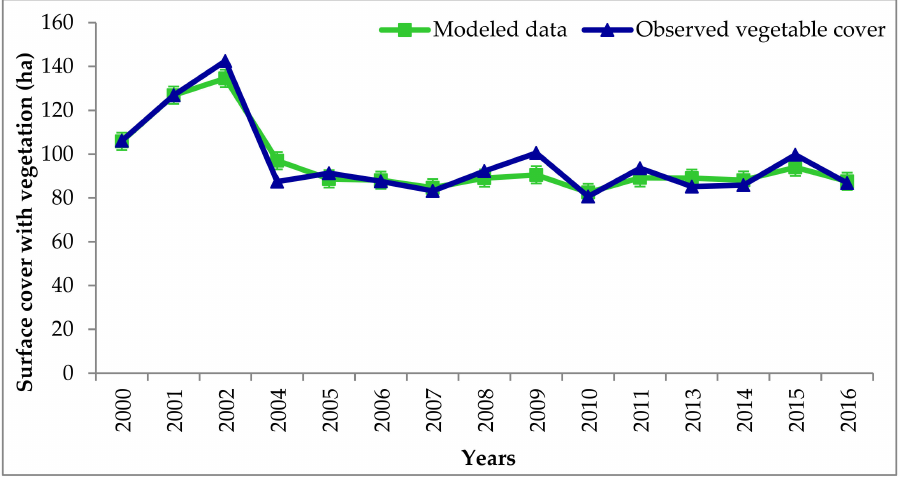
Figure 7. Modeled vegetation areas (annual model) and those estimated from satellite images for the Tilopozo salt meadows,